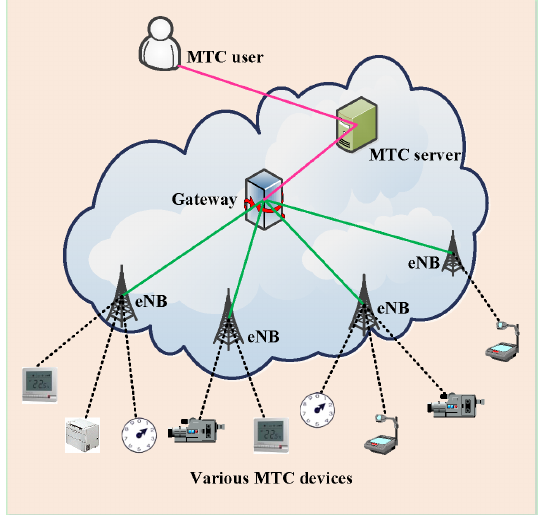
Figure 1. M2M communications in LTE-Advanced cellular networks towards